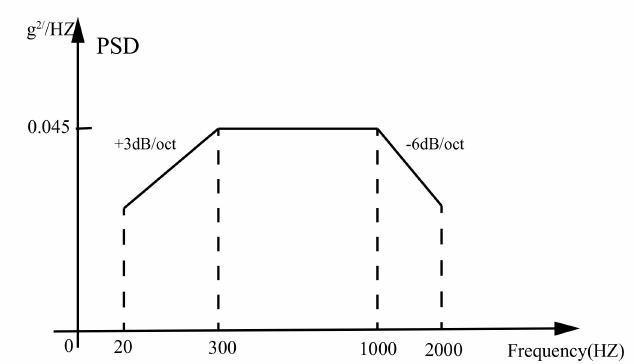
Figure 1. The power spectrum density and frequency range of the vibration experiment.